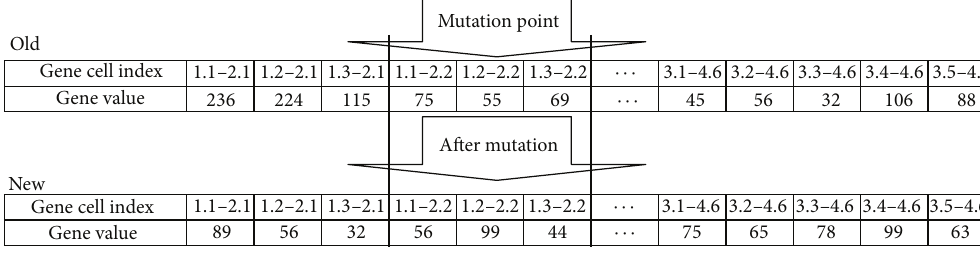
Figure 6: Mutation process.